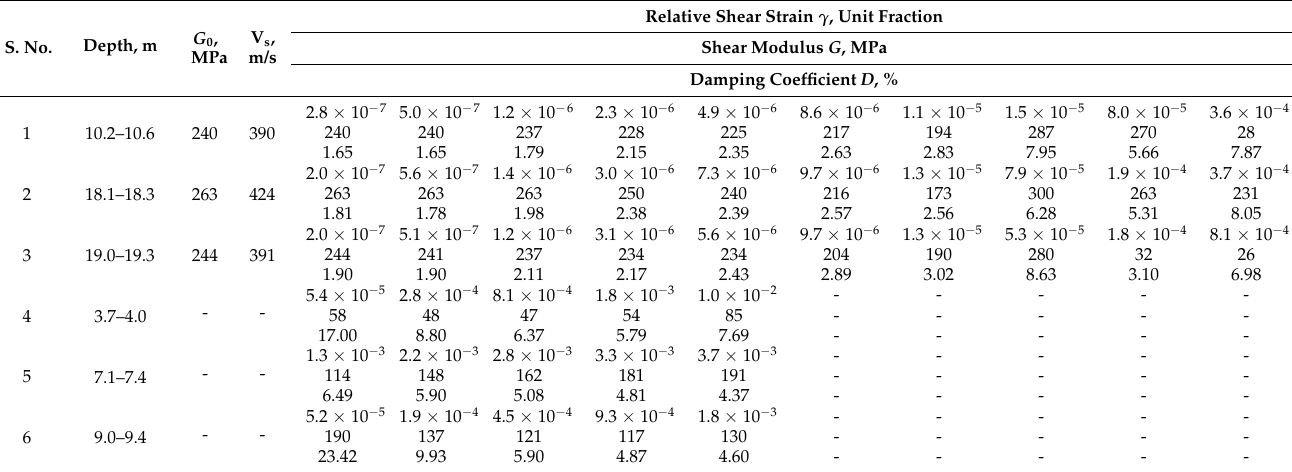
Table 2. Investigated dynamic properties for the investigated cement-stabilized